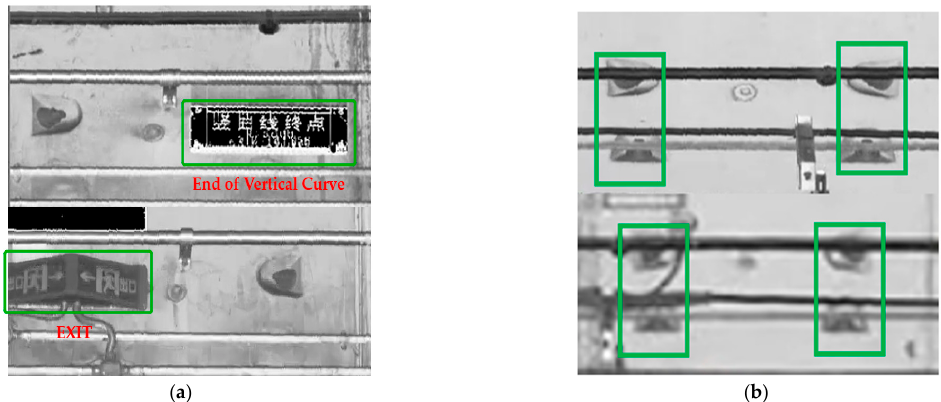
Figure 13. Shielded bolt holes that were ( a ) completely and ( b ) partially blocked.